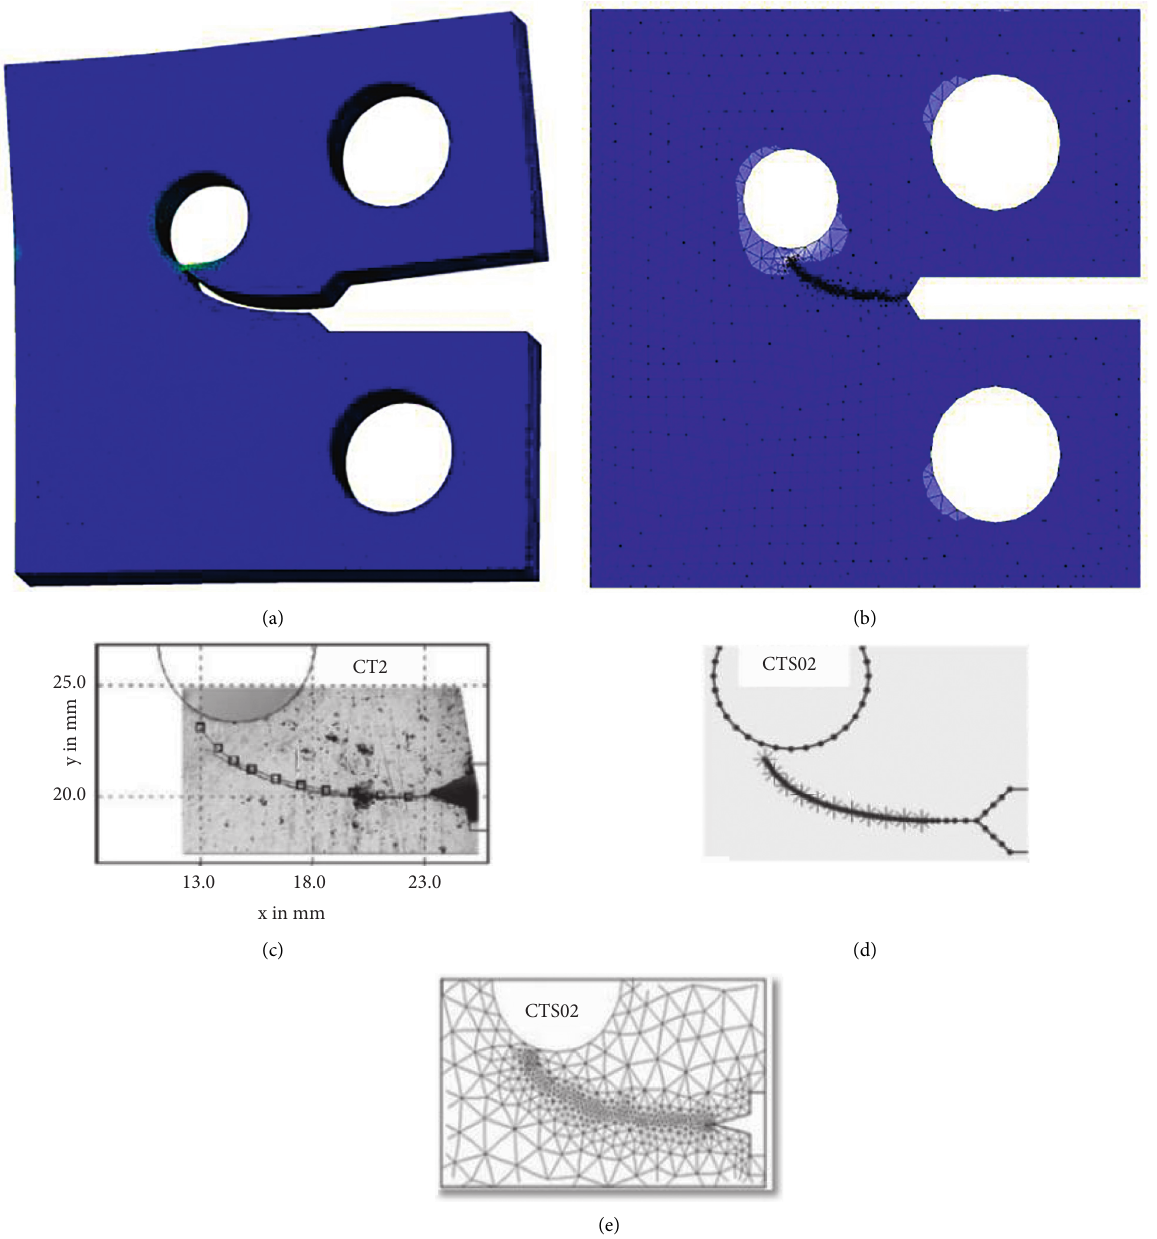
Figure 6: The predicted crack path of CTS02. (a) ANSYS results, (b) FRANC2D/L, (c) experimental and numerical results of [50], (d) BemCracker2D software [32], and (e) Quebra2D software